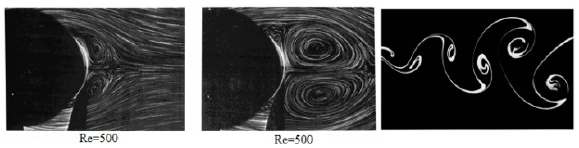
Fig. 5. On the left CSACE when flowing around a circular cylinder, on the right track of Karmein.